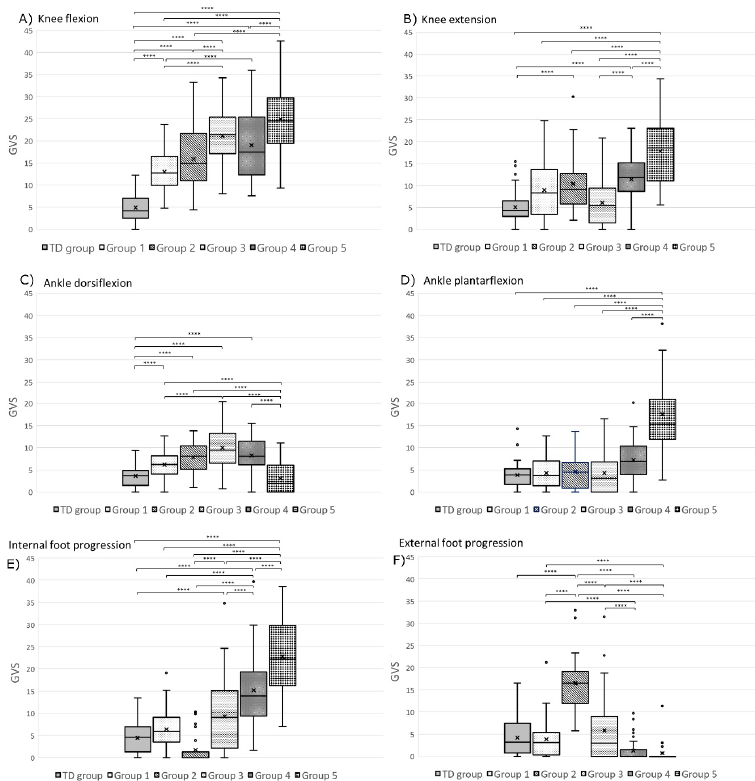
Figure 6. Box plot representation of the gait variable score (GVS) distribution at the knee ( A ) flexion and ( B ) extension), ankle ( C ) dorsiflexion and ( D ) plantar flexion, and for the foot progression angle ( E ) internal and ( F ) external for each group. In the box plots, the boundary of the box closest to zero indicates the 25th percentile, a black line within the box marks the median, the cross inside the box marks the mean, and the boundary of the box farthest from zero indicates the 75th percentile. Whiskers above and below the box indicate the 10th and 90th percentiles. Points above and below the whiskers indicate outliers outside the 10th and 90th percentiles. TD group: typically developing children (control group). Statistical differences between groups are noted with **** p < 0.0001. A movement analysis profile (MAP) representation [8] for each group is presented in Figure 7, comparing the GVSs of Group 1 to 5 with the typically developed children’s GVSs. For Group 1, we observed that GVSs of the children with CP included in this group had similar GVSs as the TD children, except for pelvic obliquity and knee flexion (Figure 7; MAP Group 1). Children with CP included in Group 2 had a higher score than TD children for all variables except for inward foot progression angle (Figure 7; MAP Group 2). Group 3 children with CP had higher GVSs than TD children except for hip extension GVS score (Figure 7; MAP Group 3). Children with CP in Groups 4 and 5 had higher GVSs than TD children except for outward foot progression angle (Figure 7; MAP Groups 4 and 5). However, children with CP in Group 5 had similar GVSs as TD children for hip extension, hip abduction/adduction, and ankle dorsiflexion (Figure 7; MAP Group 5).